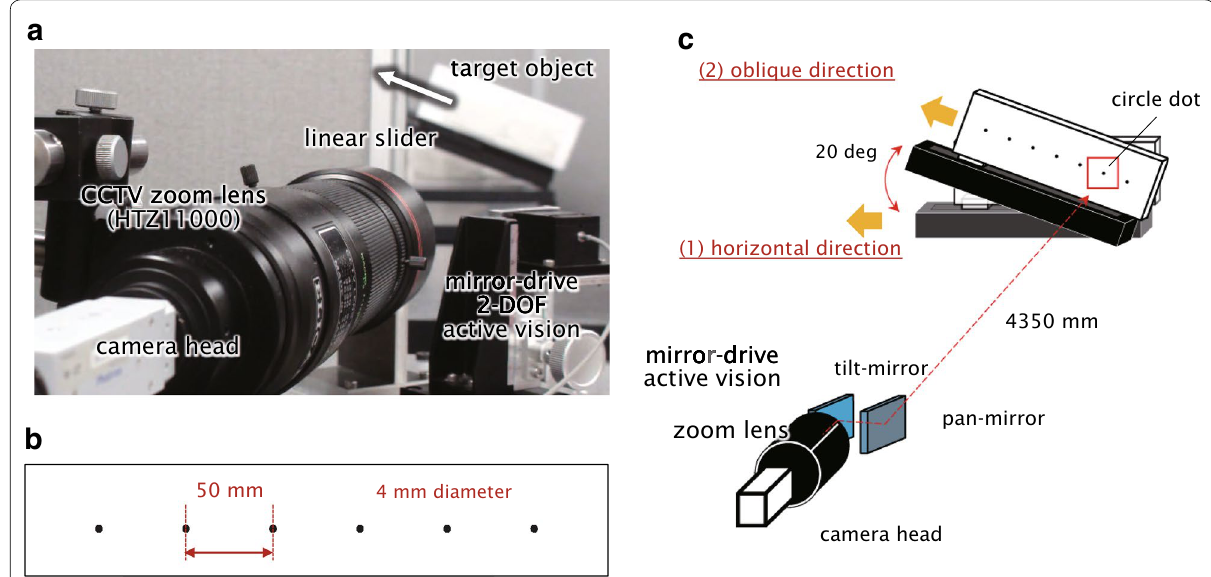
Fig. 10 Experimental environment and circle-dot pattern to be evaluated. a Overview. b Circle dots to be evaluated. c Experimental